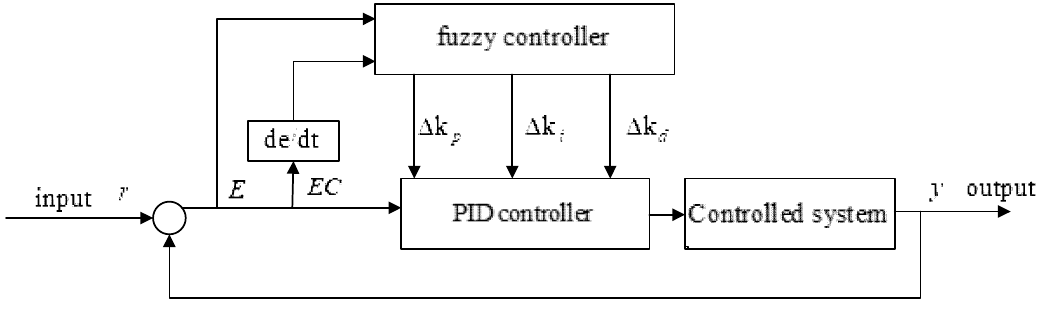
Figure 8. Structure of the fuzzy PID controller.